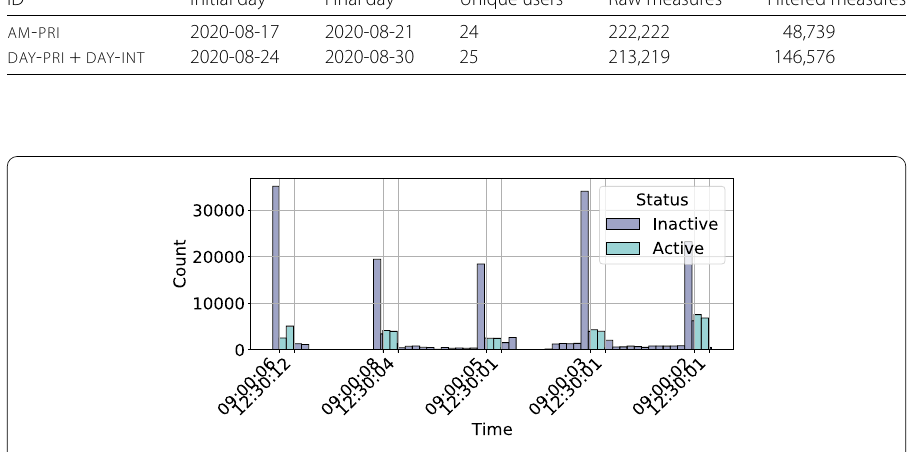
Figure 8 Filtering of the spurious measures. Distribution of the measurements over the entire sampling period, either with Active or Inactive status for AM - PRI